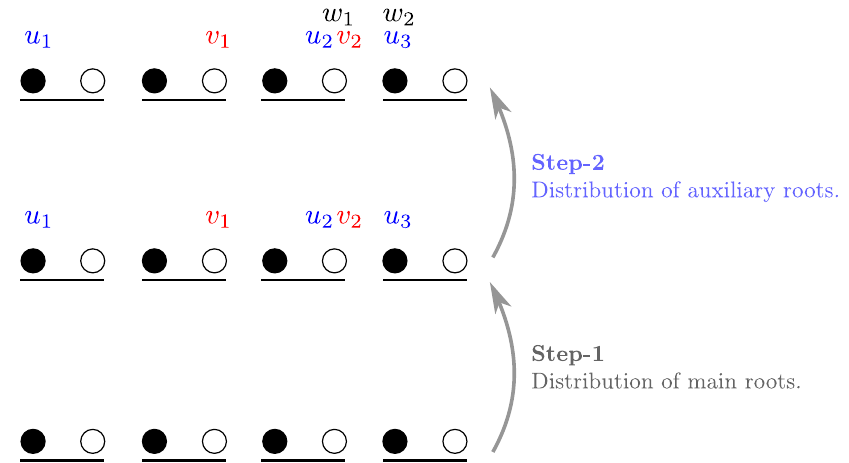
Figure 2 . Construction of (one of) the Bethe string configuration corresponding to the ket state tr( Y 2 ¯ Y )( Y 1 ¯ Y )( Y 1 ¯ Y )( Y 3 ¯ Y ) = | 2 , ¯4 , 1 , ¯3 , 1 , ¯1 , 3 , ¯4 i 4 3 1 4